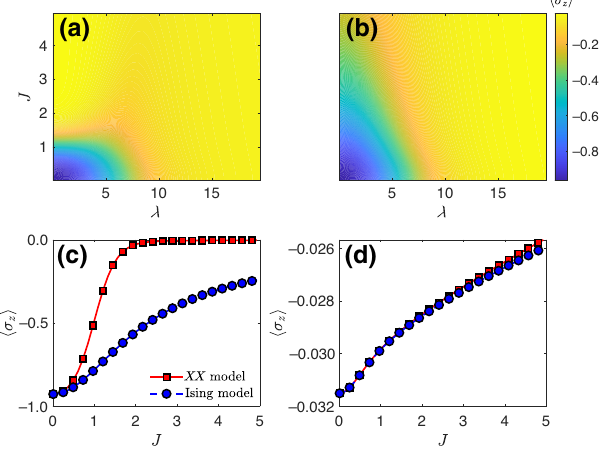
FIG. 11. (a),(b) The equilibrium magnetization in a two-qubit model, plotted as a function of the interaction strength J and the coupling parameter λ using the RC-QME method for both (a) the XX -type and (b) the Ising-type interactions. (c),(d) Cuts of the contour at weak and strong λ , respectively: (c) λ = 1.5; (d) λ = 17. The parameters are (cid:11) (cid:5) = 10.